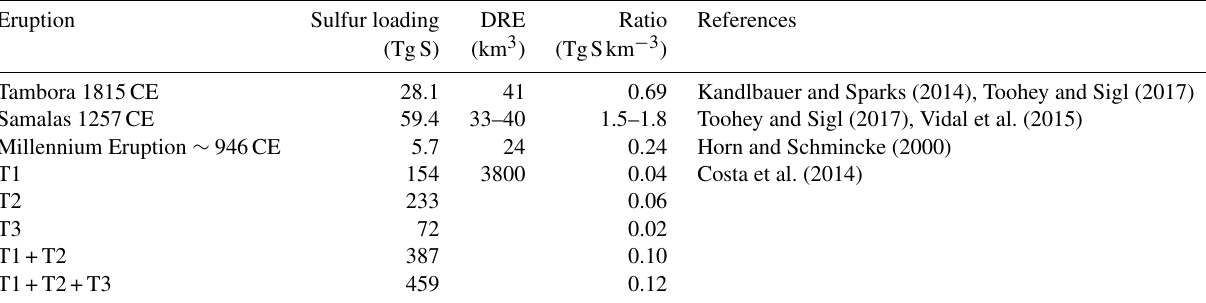
Table 1. Comparison of the sulfur loading estimates derived from ice cores and DRE for volcanic eruptions through time and the Toba candidates in this study. The sulfur loading estimate for the ME eruption was calculated following the methodology of Toohey and Sigl (2017) from sulfur deposited in the ice core records (Sigl et al., 2015; Sun et al.,